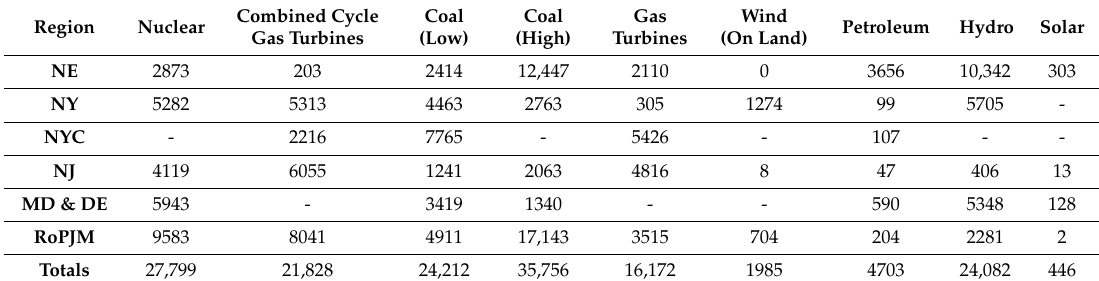
Table A1. Initial Capacity by Region (in MW) (Cambridge Energy Solutions, 2011).